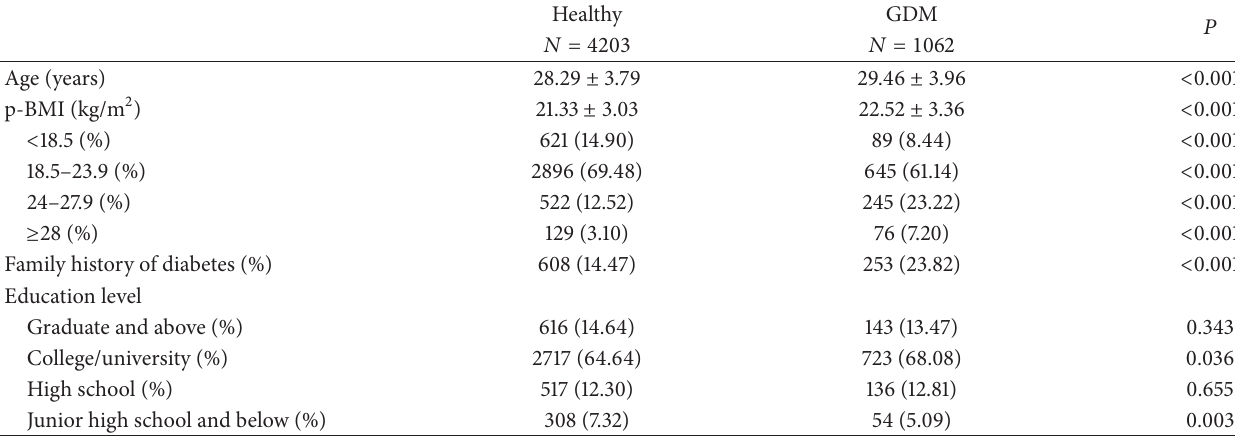
Table 1: Maternal baseline